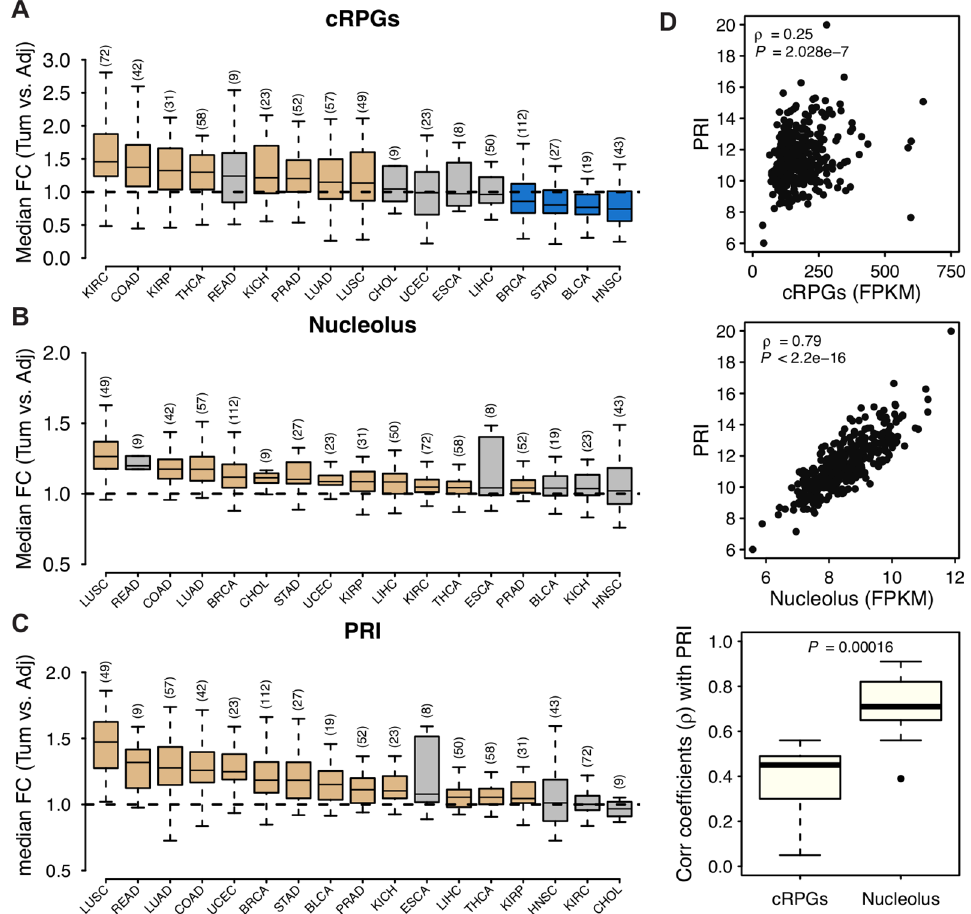
Fig 7. Nucleolar gene expression and proliferation in cancer-adjacent tissue pairs. (A-C) Changesin the level of expressionof (A) cytoplasmic ribosomalprotein genes(cRPGs), (B) nucleolar genesas well as (C) PRI in tumors relative to their normal adjacent tissue within each individual. Seventeen cancer types with RNA-seq data in (cid:21) 5 tumor-adjacent pairs were shown, with sample sizes in brackets. Yellow and blue indicatesignificant up- and down- regulationin tumors comparedwith pairedadjacent control tissue (Wilcoxonrank sum test P < 0.01), respectively. Non-significant changesare shown in grey. (D) PRI is more strongly correlated with the expressionof nucleolargenes than with the expressionof cRPGs. The upper two panels show the correlations of cRPGs and nucleolargenes with PRI in BLCA as an example,while the lower panel summarizesthe Spearman’s correlationcoefficientsin all 17 cancer types ( P from pairedWilcoxon rank sum test). COAD, colon adenocarcinoma; KIRP, kidney renal papillarycell carcinoma;THCA, thyroid carcinoma;READ, rectum adenocarcinoma; KICH, kidney chromophobe; PRAD, prostate adenocarcinoma; CHOL, cholangiocarcinoma; UCEC, uterine corpus endometrial carcinoma; ESCA, esophageal carcinoma.Other abbreviationsare as in (S6A Fig, Spearman’s ρ = 0.53–0.89, P < 2.2e-16). Furthermore, we observed significantly increased PRI for almost all cancer types (Fig 7C and S6B Fig) with LUSC, LUAD, and STAD